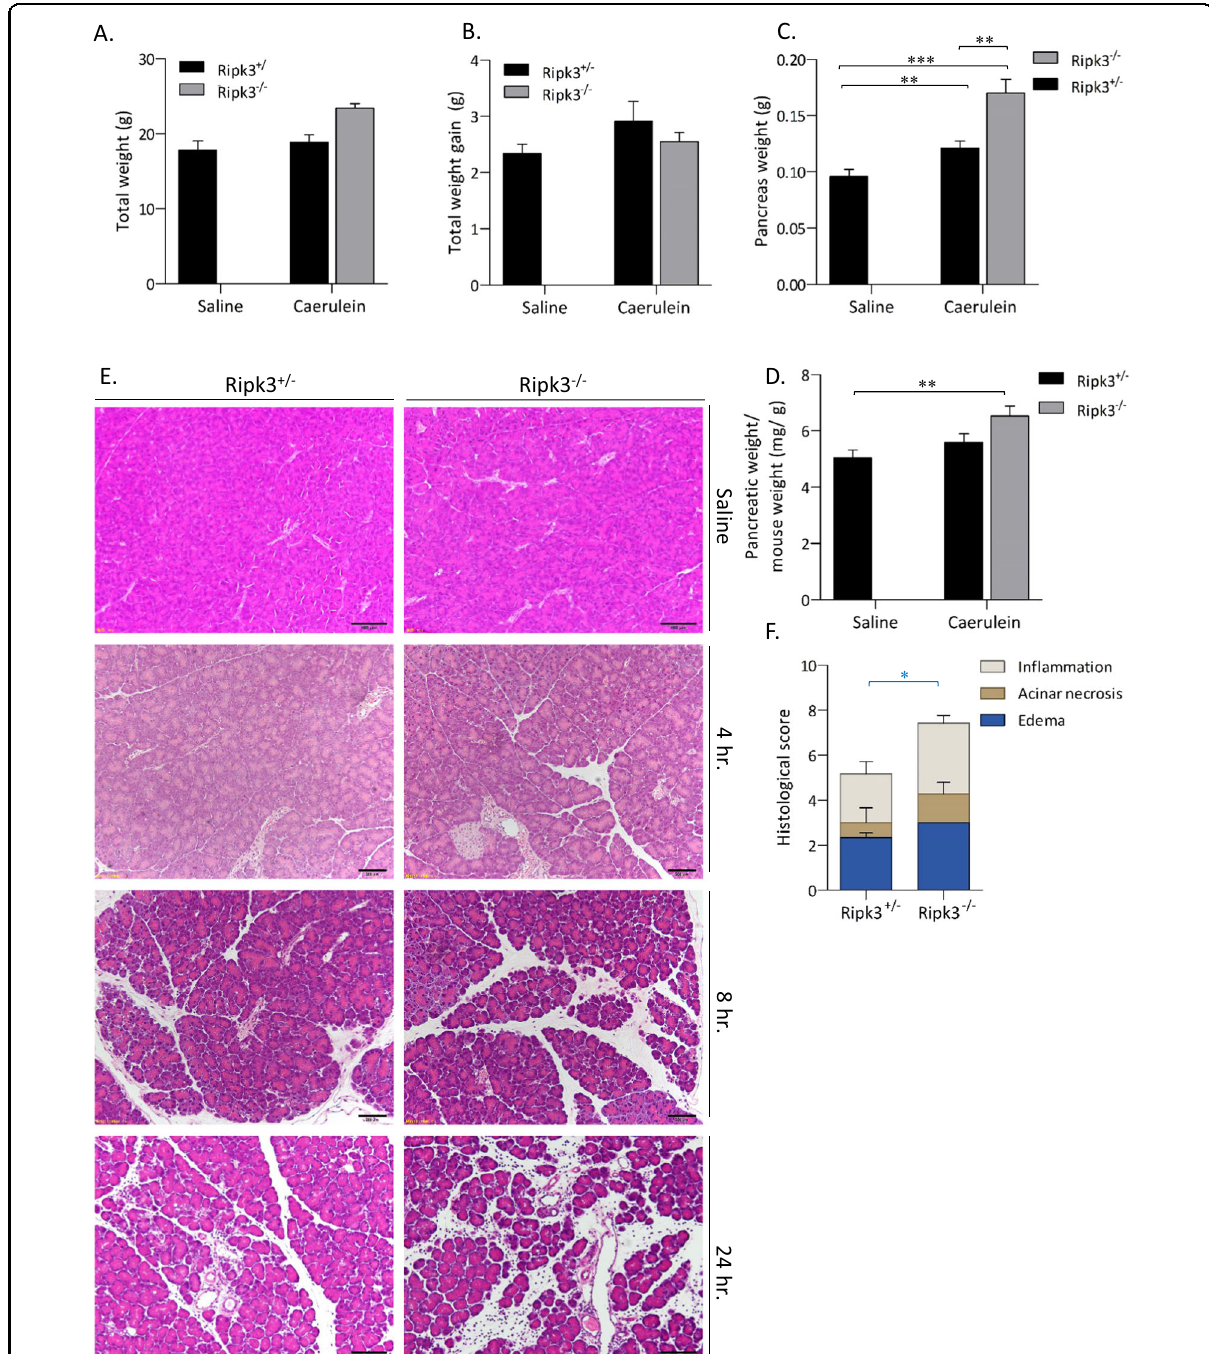
Fig. 5 Ripk3 − / − mice exhibited exacerbated pancreatic tissue damage in vivo. Ripk3 + / − and Ripk3 − / − mice were intraperitoneally injected with either 100 µg/kg caerulein or saline every hour for eight consecutive hours. The mice were sacri fi ced at 4, 8, and 24 h after the fi rst injection ( n = 6 − 8 in each group). A The total body weight and B weight gain were determined. The pancreas weight is shown as the absolute weight ( C ) or as a percentage of the fi nal body weight ( D ). E Representative H&E images of pancreas tissue. F Histological scores of pancreatic sections from Ripk3 + / − and Ripk3 − / − mice treated with caerulein showing pancreatic edema, acinar necrosis, and in fl ammation. There were no signi fi cant differences in any parameters such as edema, necroptosis, and in fl ammation. The data are presented as the means ± SEMs. * P < 0.05, ** P < 0.01, and *** P < 0.001. These data are representative of three